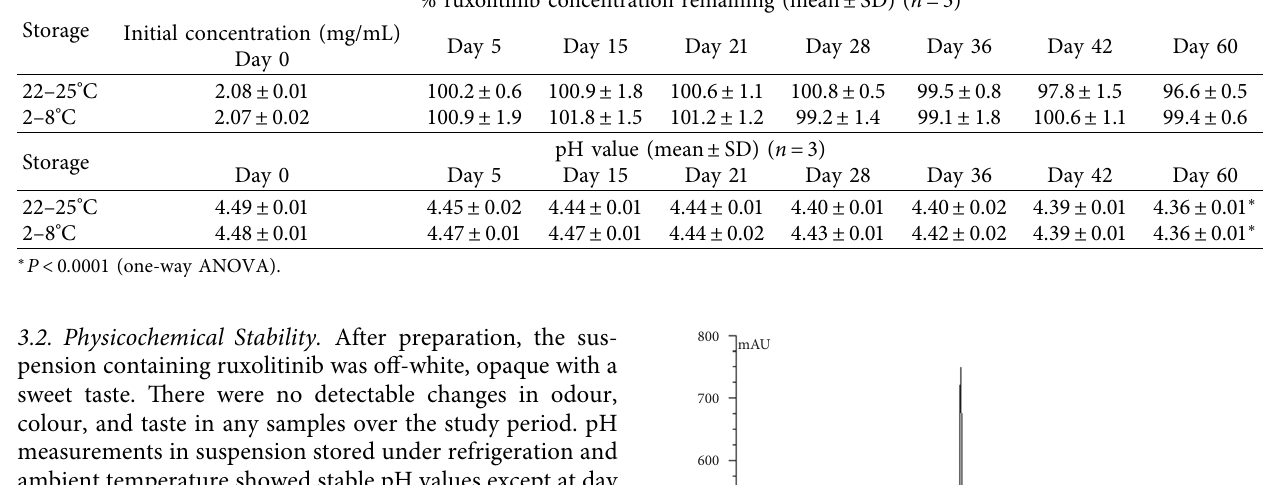
Table 3: Stability of ruxolitinib phosphate 2 mg/mL oral solution stored at 22–25 ° C and 2–8 ° C for 60 days.